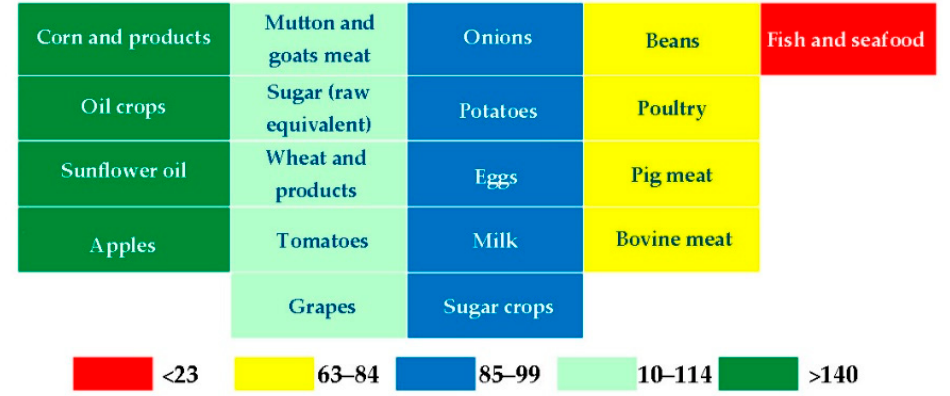
Figure 3. Heatmap, Self-sufficiency in the Western Balkan region as a whole. Source. The authors’ calculation.